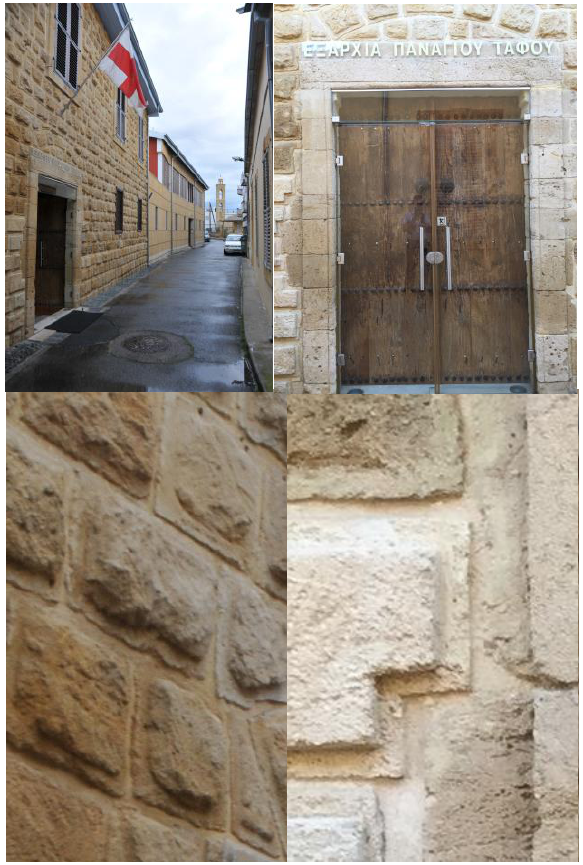
Figure 9. Repositories of materials and masonry arrangements: the Nicosia’s Patriarchate external wall